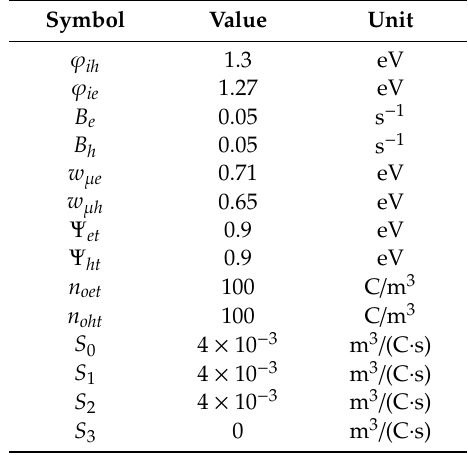
Table 3. Simulation parameters based on the BCT model.